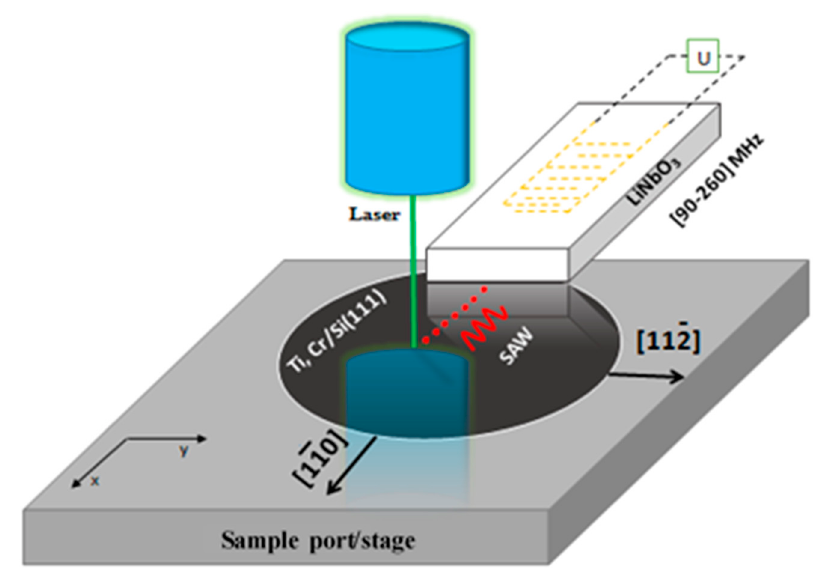
Figure 6. Schematic diagram of the measuring principle.